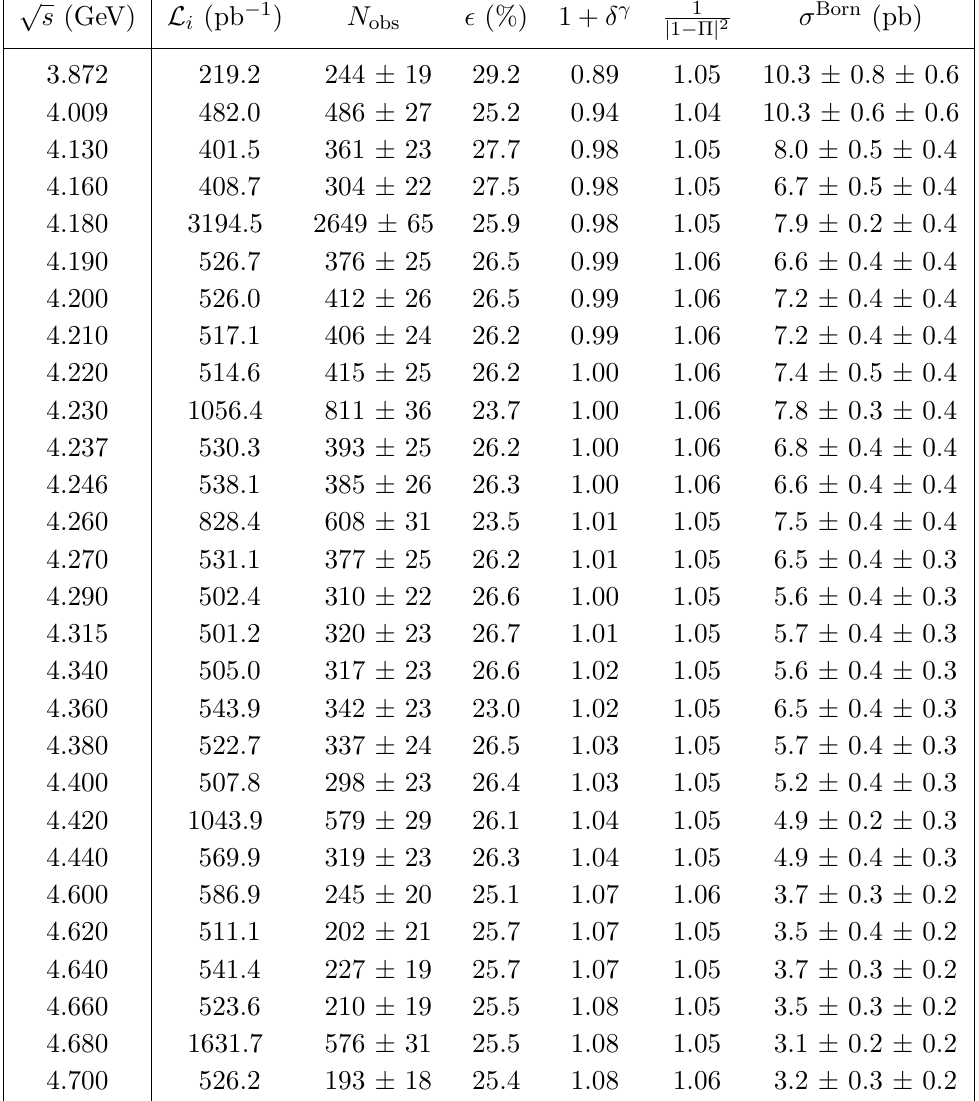
Table 2 . Numerical results for e + e − → ηπ + π − . The first uncertainties for cross sections in the most right column are statistical uncertainties and the second ones are systematic uncertainties, while those for N are statistical obs